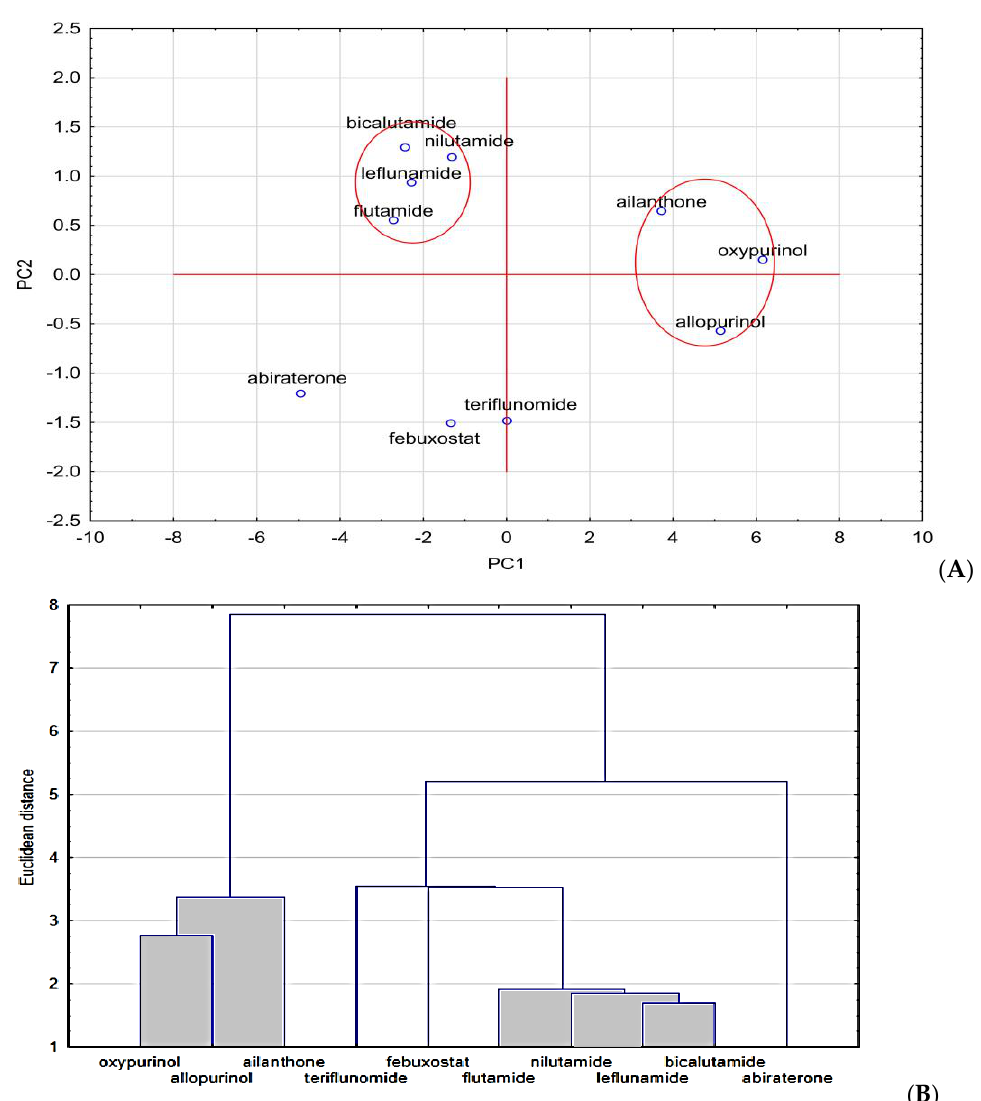
Figure 6. Graph prepared on the basis of principal component analysis ( A ) and cluster analysis ( B ) for all tested compounds in terms of their lipophilicity values, both experimental and theoretical.